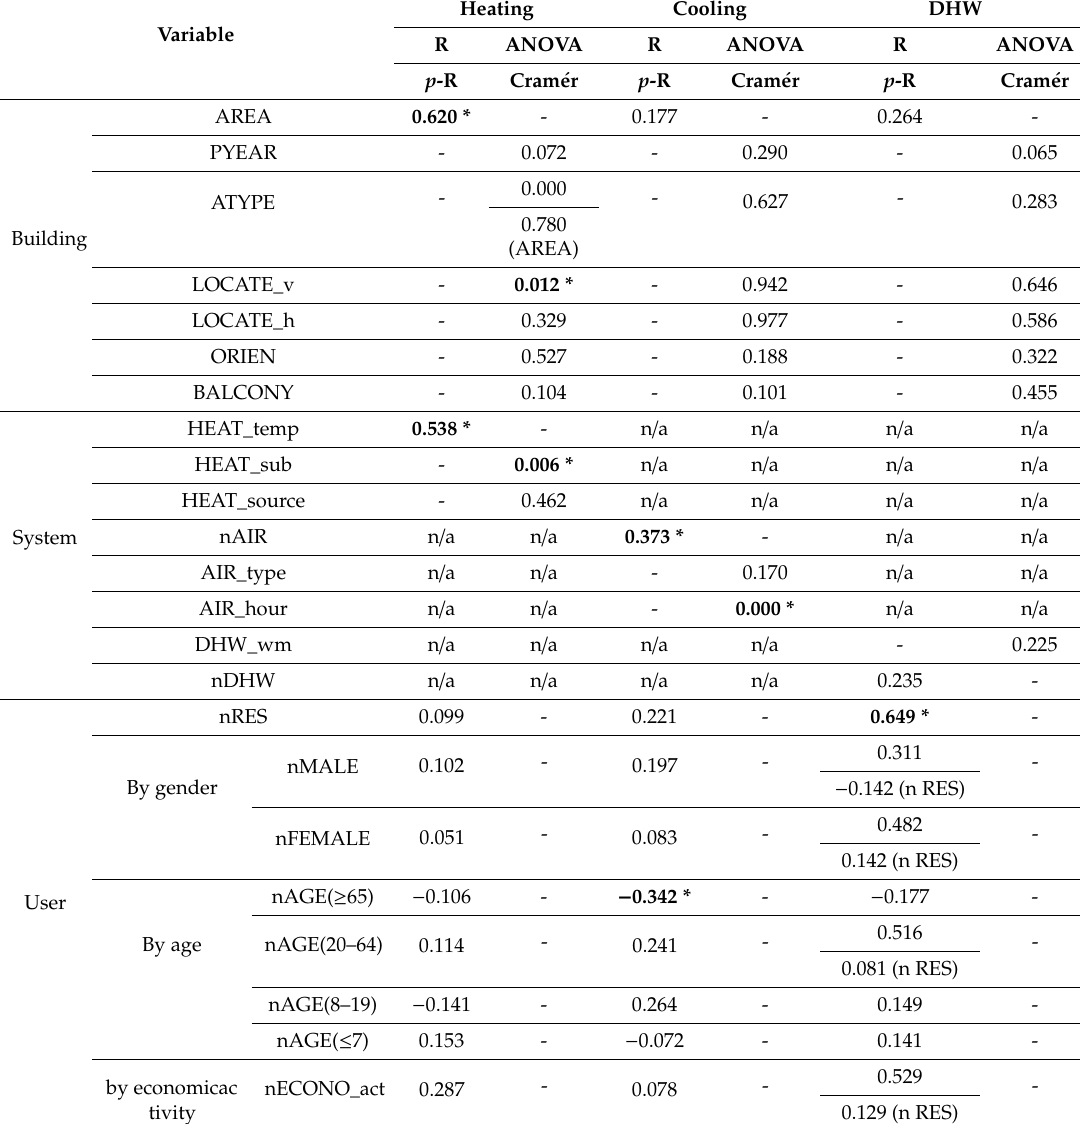
Table 3. Correlation analysis for ratio-scale and analysis of variance (ANOVA) for nominal-scale results 1,2 : heating, cooling, and